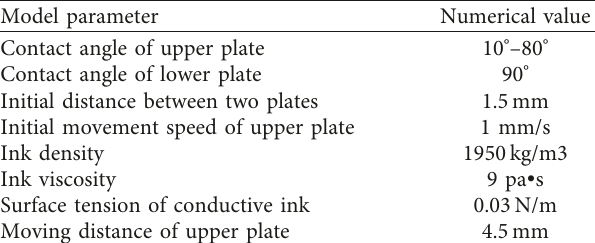
Figure 9: Grid division of ICEMCFD two-dimensional model. (a) Model region division. (b) Structured grid region. (c) Unstructured grid region. Table 3: Basic simulation